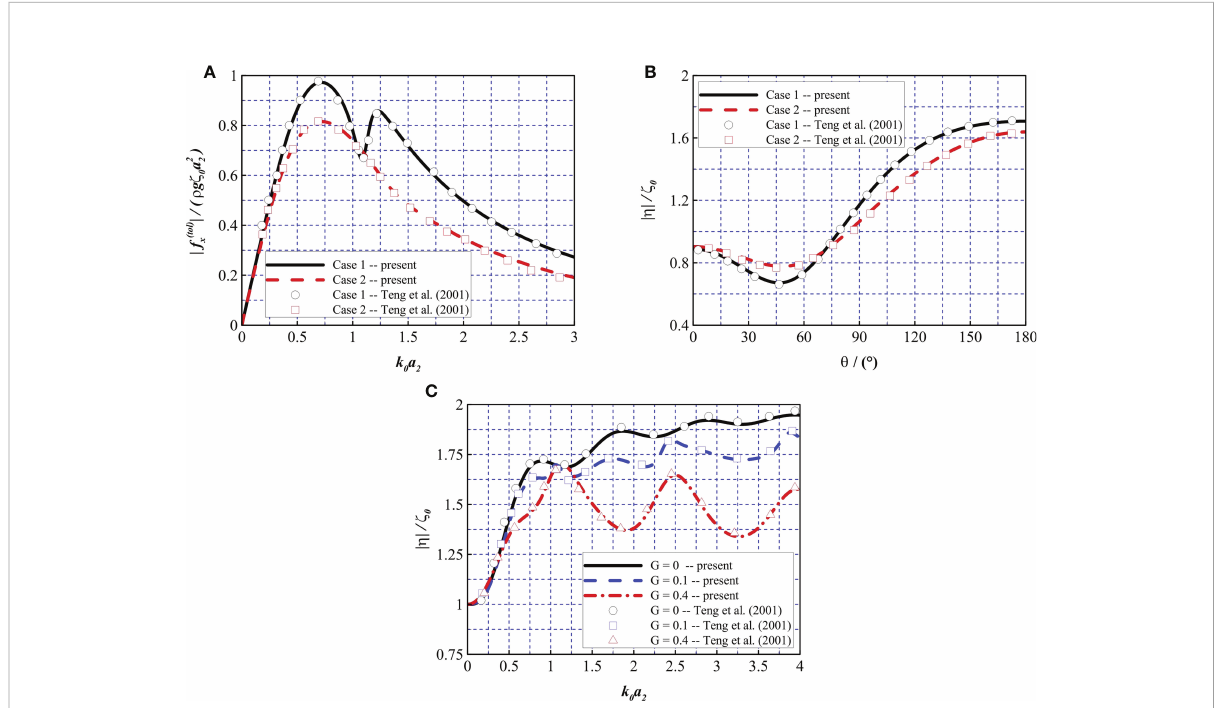
FIGURE 4 Comparison of the non-dimensional force and wave elevation to the results derived by Teng et al. (2001). (A) j f ( tol ) x j = ( r g z 0 a 2 2 ) and (B, C) | h |/ z 0